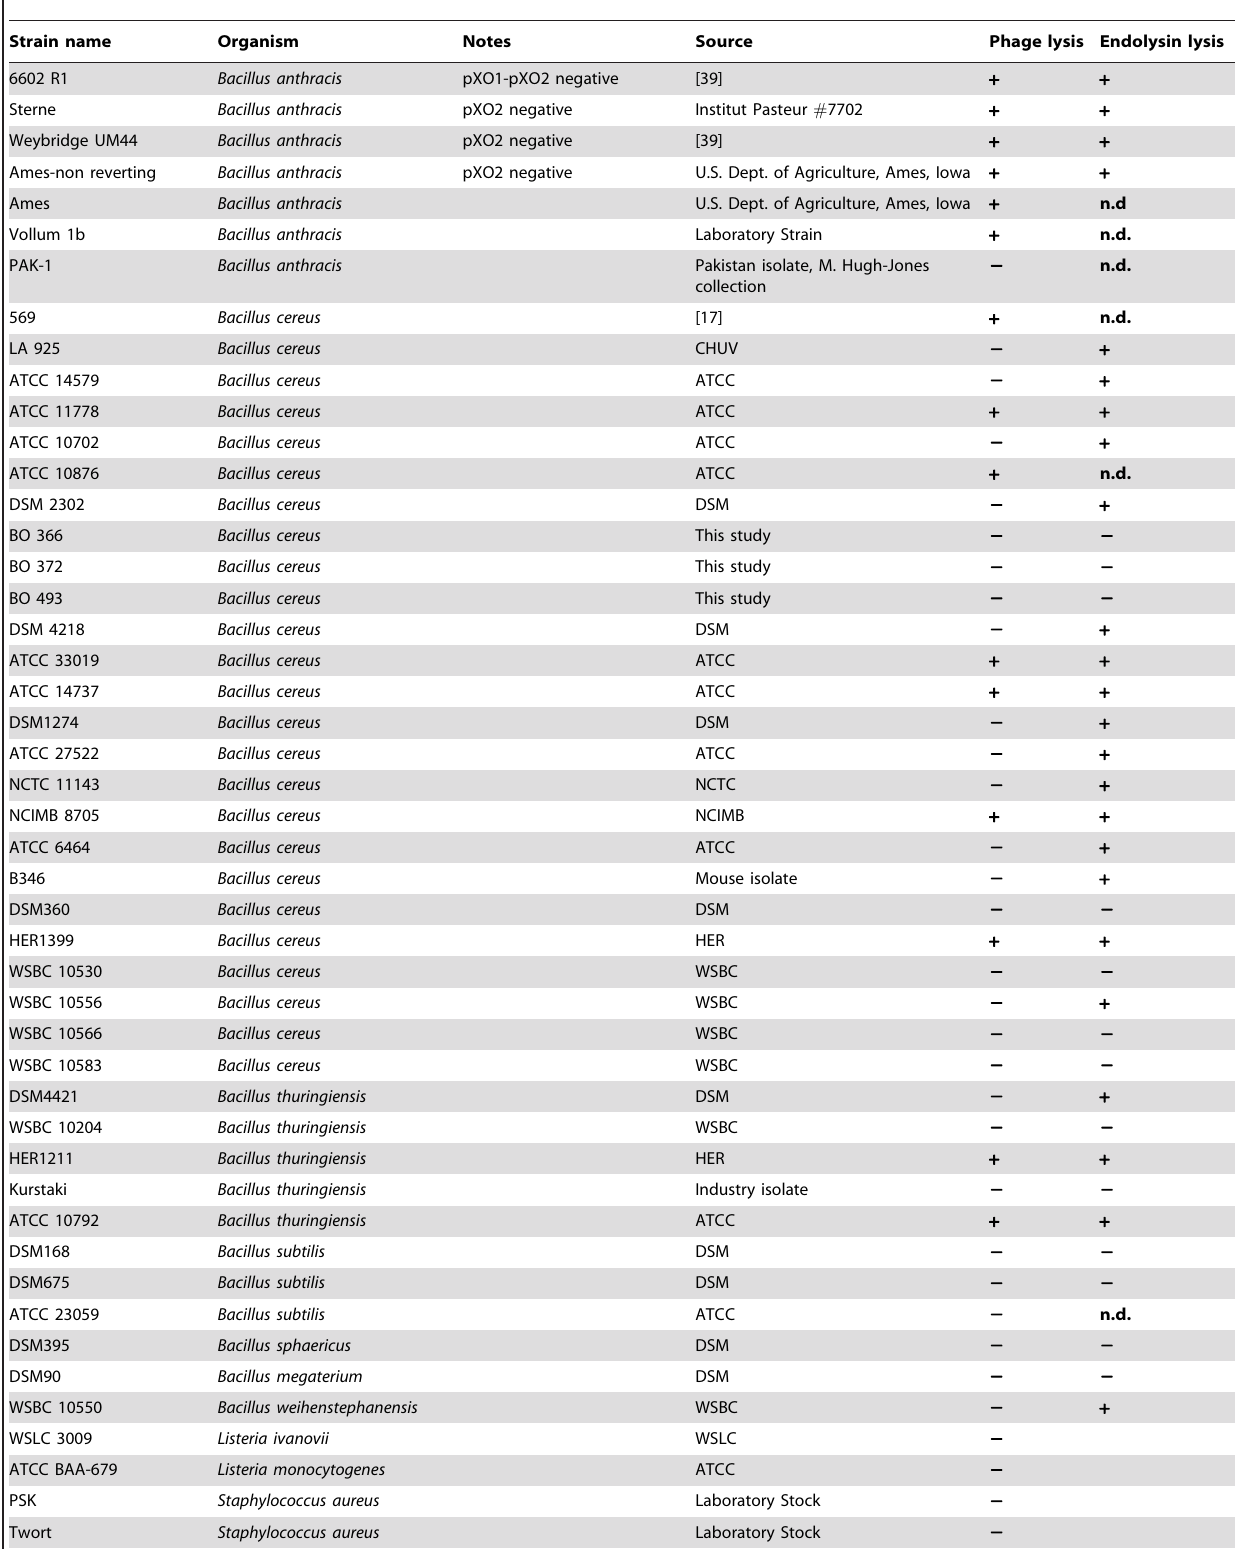
Table 1. Host range of Tsamsa phage on 43 different Bacillus strains and 12 non- Bacillus strains and lytic spectrum of Tsamsa endolysin for a subset of the Bacillus strains. Presence of lysis is indicated by + and absence of lysis is indicated by -. n.d.: not